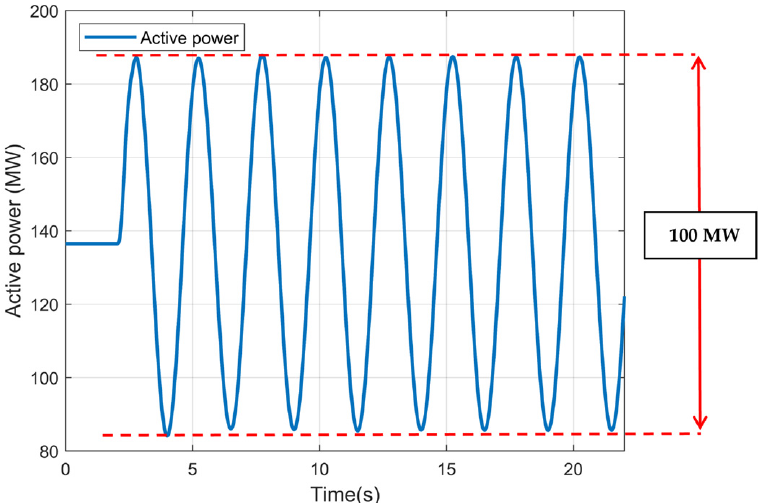
Figure 3. Active power output in MW of a generator with a 0.4 Hz sinusoidal wave added to the governor reference power set point.